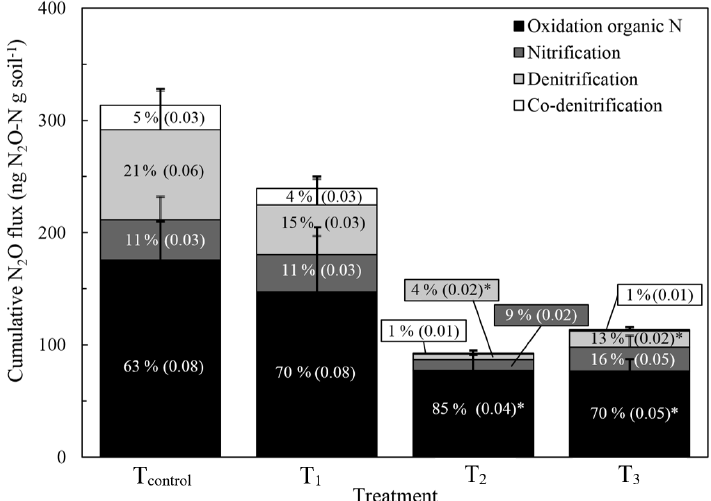
Figure 5. Cumulative N 2 O flux via four processes between 3h and 6 days after labelling. N 2 O fluxes based on average flux from soil labelled with 15 NH 4 NO 3 Gly or NH 15 NO 3 Gly. The cumulative flux per process is an average over the four plots per treatment. Error bars 4 are standard error of the mean (SEM). Percentages are the average percentage of flux produces via each process; SEM between brackets; ∗ indicates significantly lower cumulative flux compared to the control ( p < 0.05).